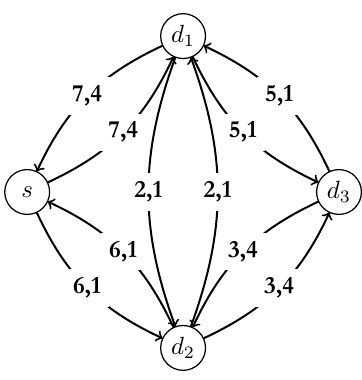
Figure 3: Auxiliary network of the network in Figure 1